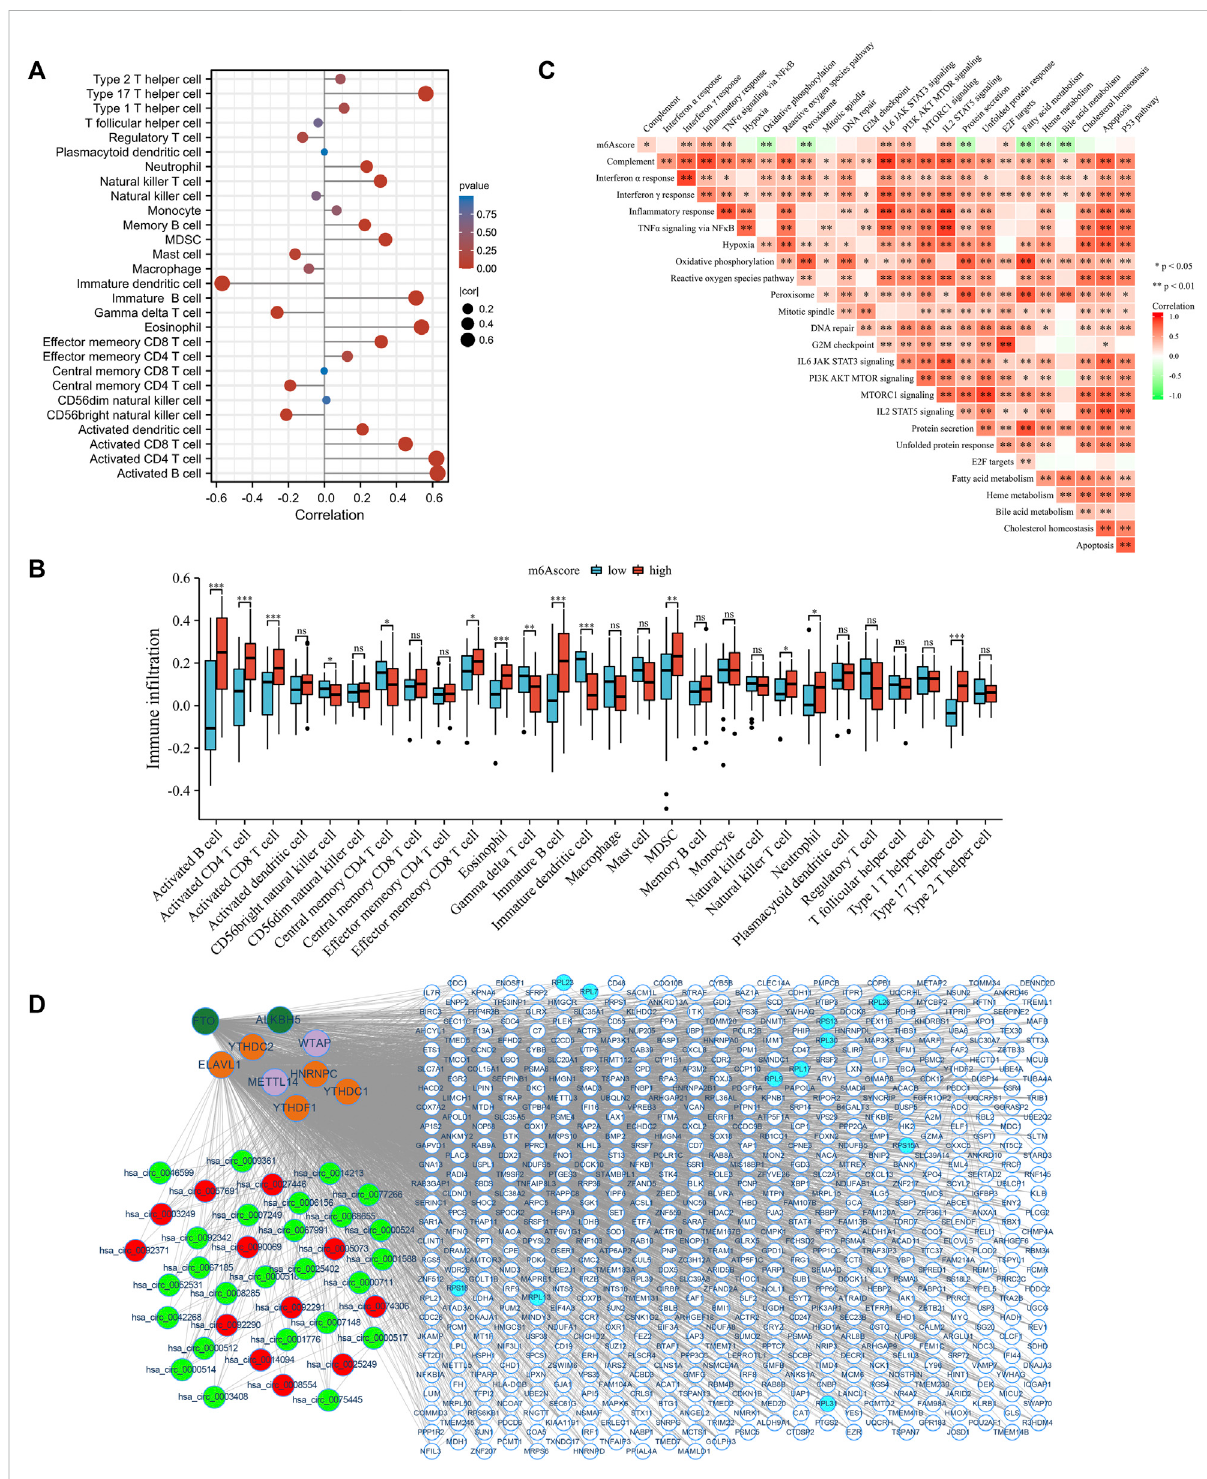
FIGURE 7 Distinction of immune environment and transcriptome characteristics in m6Ascore phenotypes. (A) The correlation between immune cells abundance and m6Ascore in GEO cohort using Spearman analysis. Correlation coef fi cients are described by circle size and x -axis. The color of the circle is scaled by p -value. (B) The correlation between hallmark gene sets and m6Ascore in GEO cohort using Spearman analysis. Positive and negativecorrelationsarecoloredwithredandgreen,respectively. (C) Therelativeabundanceofimmunecellsbetweenlowandhighm6Ascore groups. (D) Construction of circRNAs-m6A regulators-mRNA network. Red: upregulated circRNAs. Green: downregulated circRNAs. Atrovirens: erasers. Orange: readers. Purple: writers. White: DEGs. Blue: hub genes. ns: no signi fi cance; * p < 0.05; ** p < 0.01; *** p <